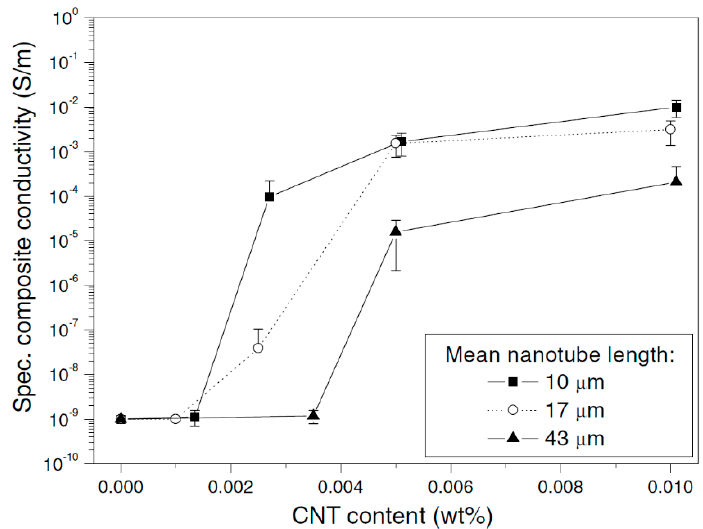
Figure 23. Variation of conductivity with CNT content for three di ff erent nanotube lengths in epoxy composites [52].